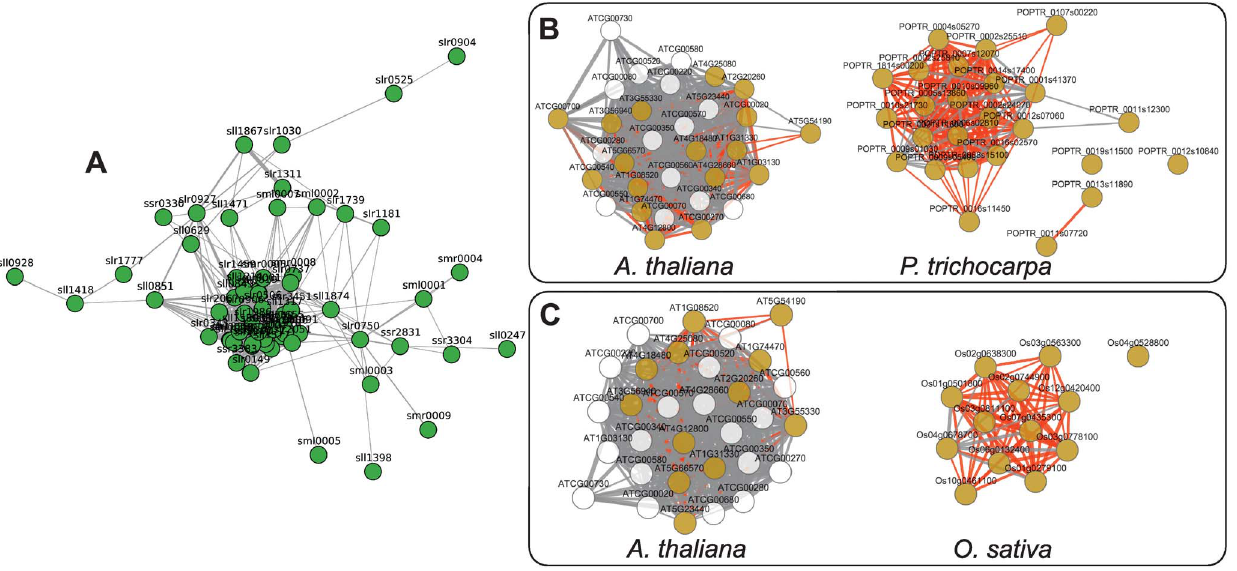
Figure 5. Conservation of photosynthesis genes. Co-expressed genes related to photosynthesis in Synechocystis (A) were BLASTed against A. thaliana . The orthologs (BLAST E-value , 1e-5) were compared against P. trichocarpa (B) and O. sativa (C) using the network comparison tool ComPlEx. This revealed conservation of co-expression across all four species. Note that the A. thaliana genes given in white color were not measurably expressed in the other